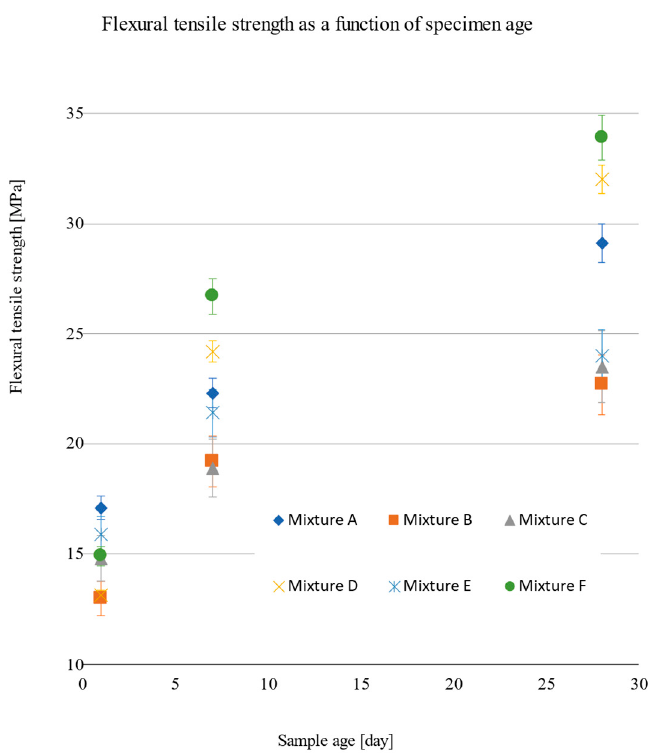
Figure 7. Compressive strength as a function of the age of the sample.